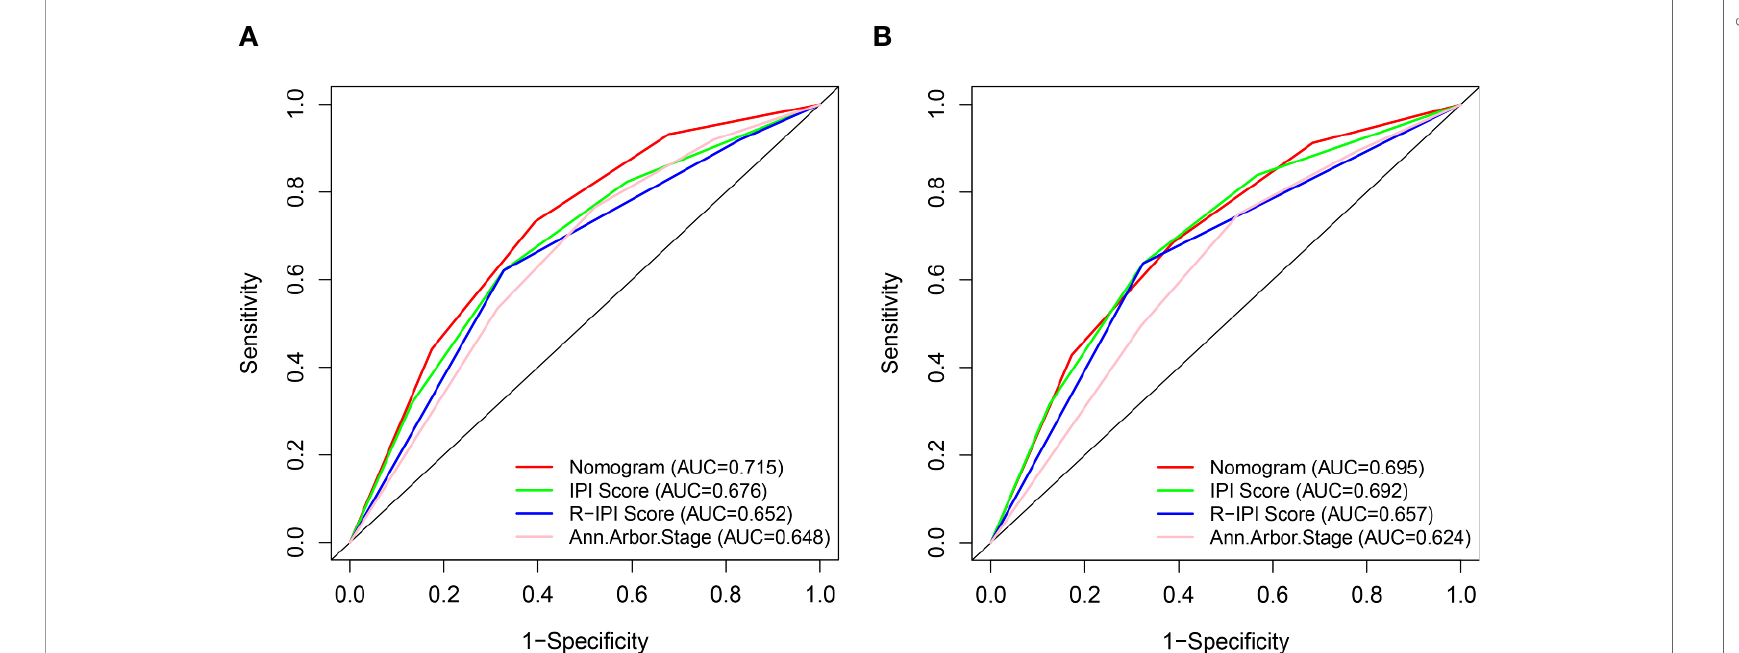
FIGURE 7 | ROC curves of the nomogram and IPI, R-IPI, and Ann Arbor stage prognostic systems for 5-year CSS prediction in the training (A) and validation cohort (B)